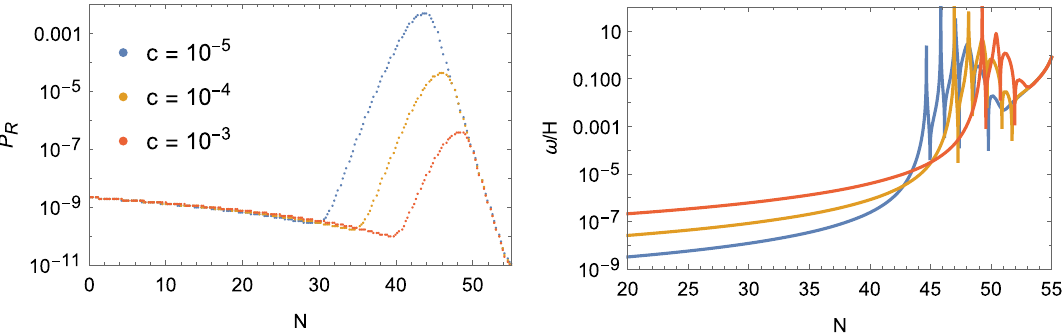
Fig. 4 The power spectrum P R ( k ) against the e-folds number N when the corresponding k -mode leaves the horizon ( k = a ( N ) H ( N ) ) for b = − f = 1 and three reference values of c (on the left). The turn-rate-to-Hubble ratio ω/ H is on the right. The color coding is the same as in Fig. 3 would have evaporated by now due to Hawking